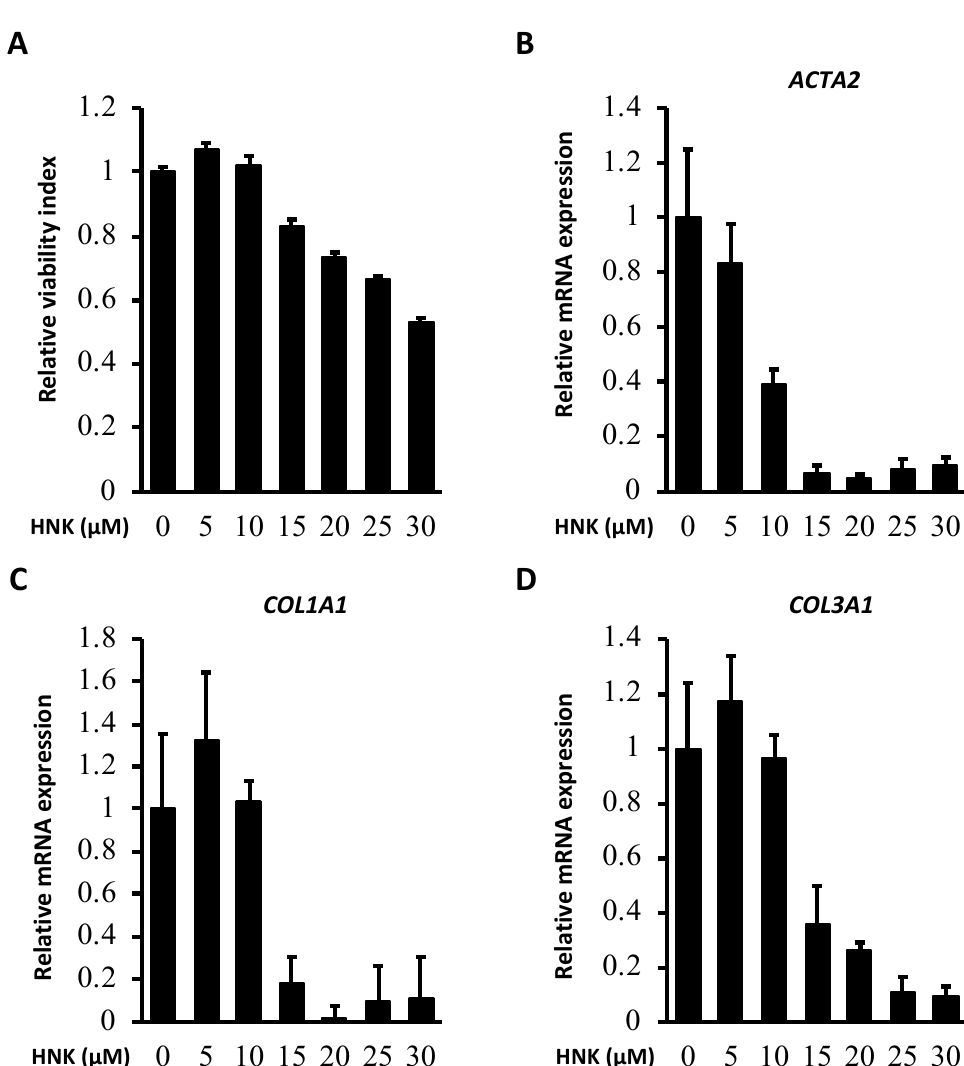
Figure 3. HNK treatment suppresses proliferative and fibrogenic activities in human activated hepatic stellate cells. Effect of HNK on proliferation and fibrogenesis of the HSC line LX-2. ( A ) Cell viability and proliferation of LX-2 cells after a 24 h incubation with the noted concentrations of HNK as determined by the WST8 method. ( B – D ) Relative expression of ACTA2 , COL1A1, and COL3A1 in LX-2 cells 24 h after incubation with the indicated concentrations of HNK. GAPDH was used as an internal control for reverse transcription-quantitative PCR. All graphs represent means ± SD.